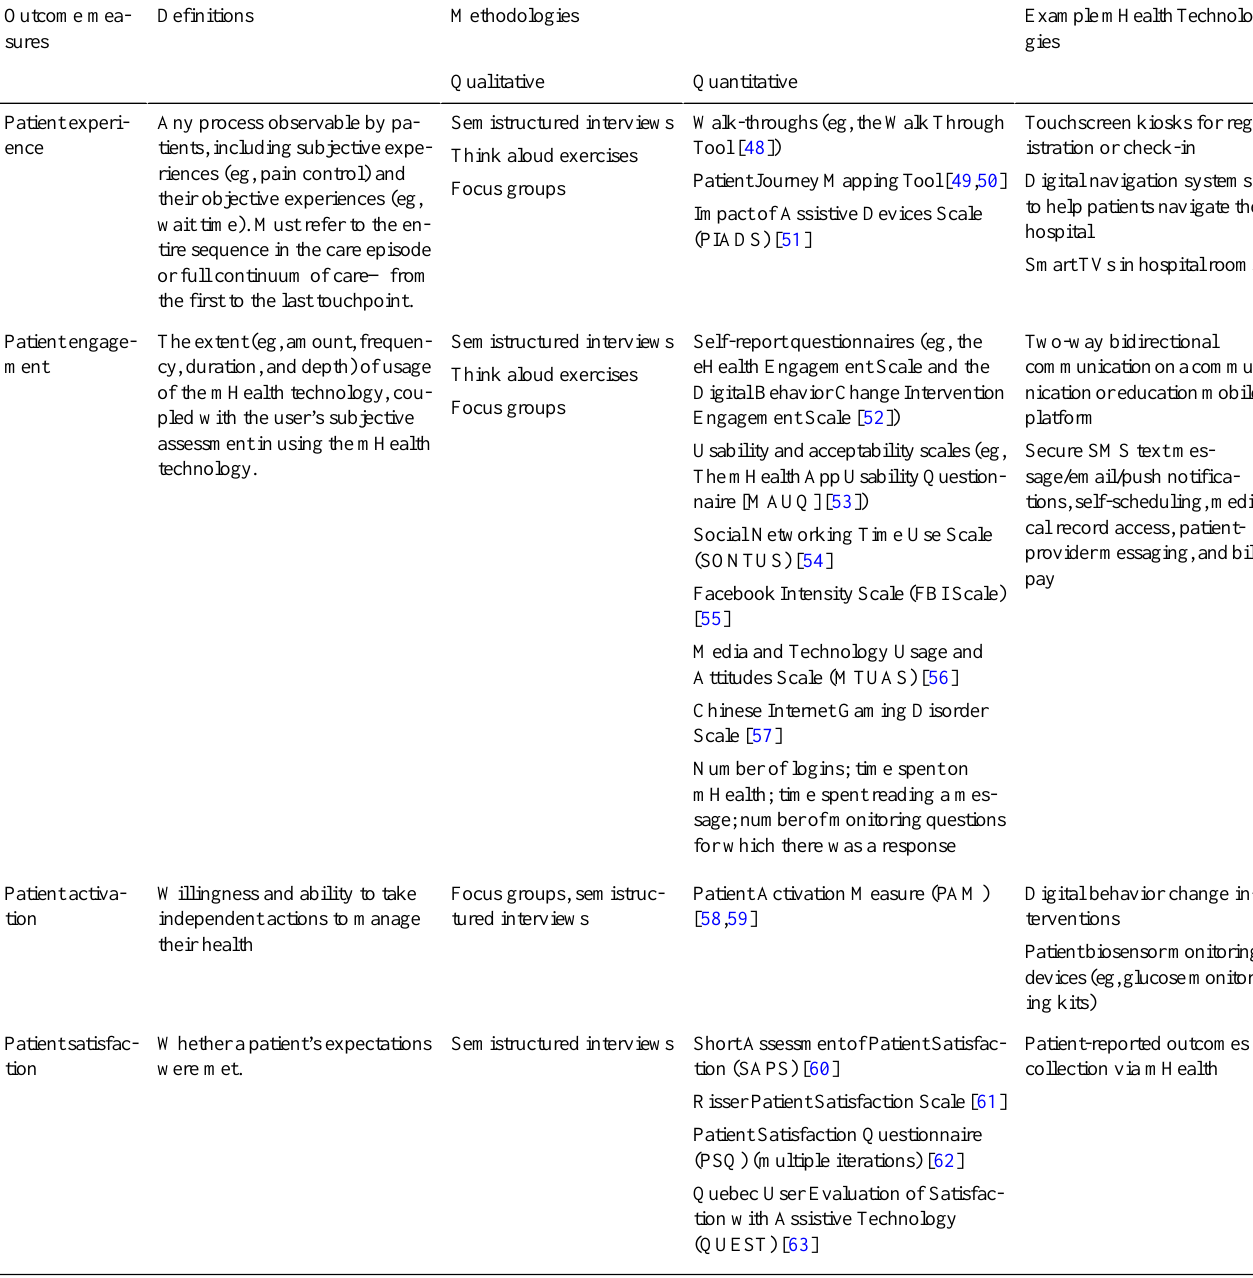
Table 1. Patient-centered mobile health (mHealth) technologies: outcome measures, methodologies, and